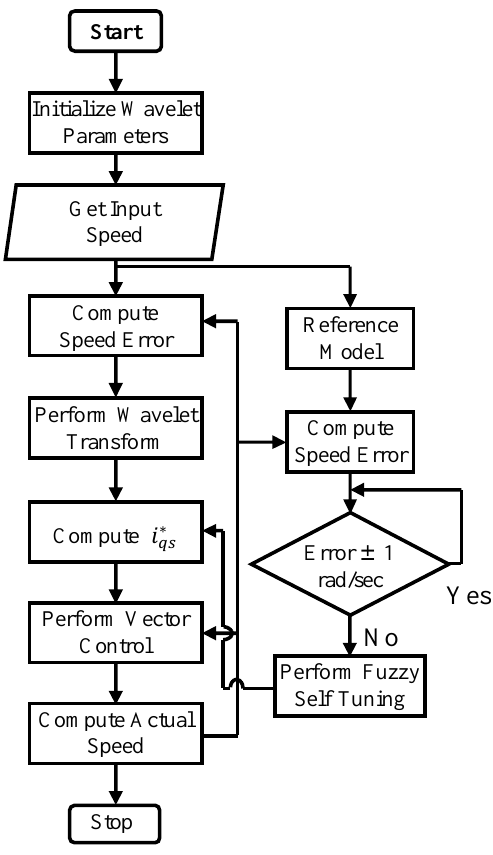
Fig. 6. Flowchart of the proposed wavelet-fuzzy control algorithm for Induction motor